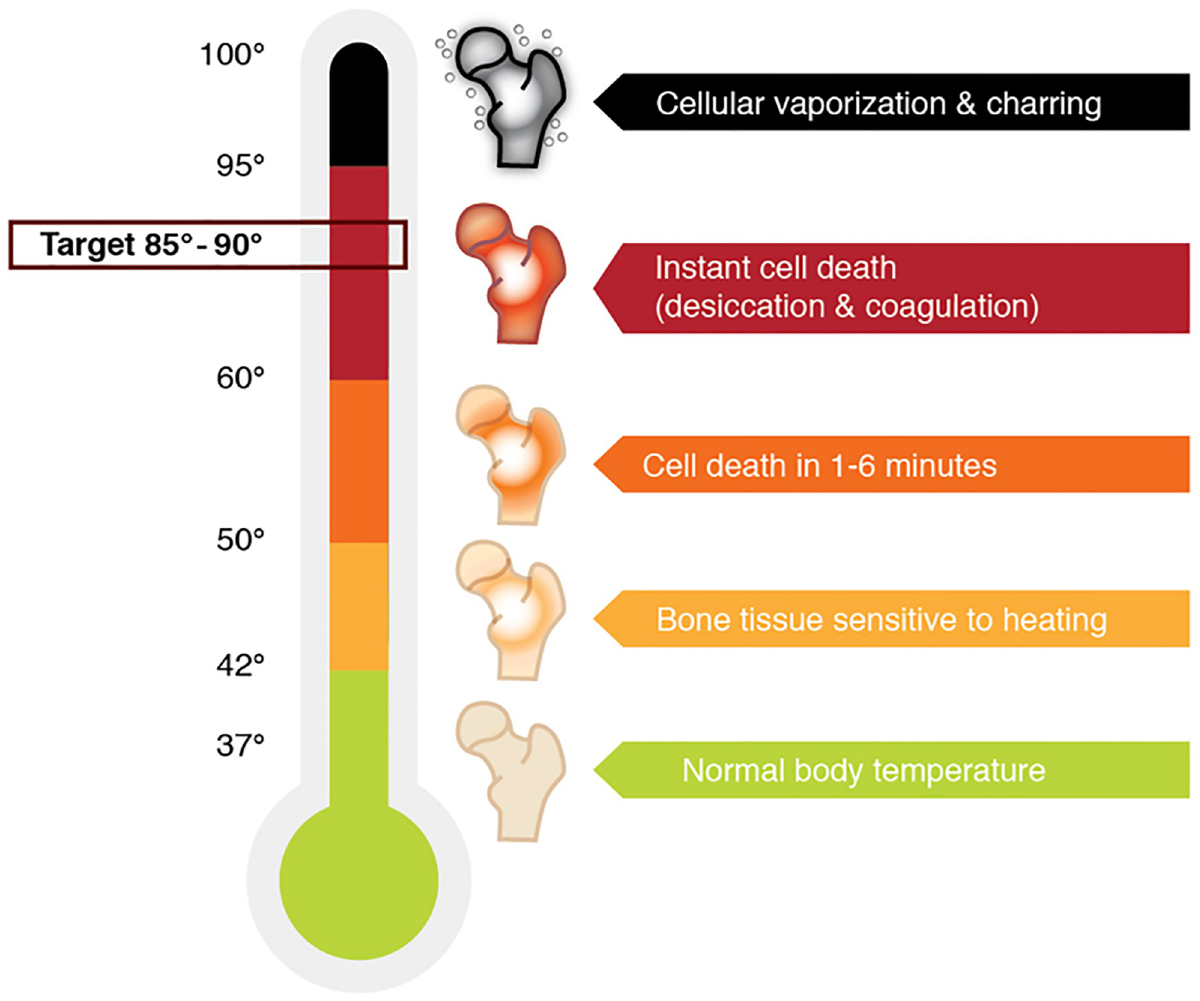
Fig 1. Tissue reaction to heat [15]. Ideal temperature for ablation is 60–95˚C since instant cell death is the aim. Below 60˚C cells may recover. Above 100˚C carbonization occurs, limiting distribution of heat.